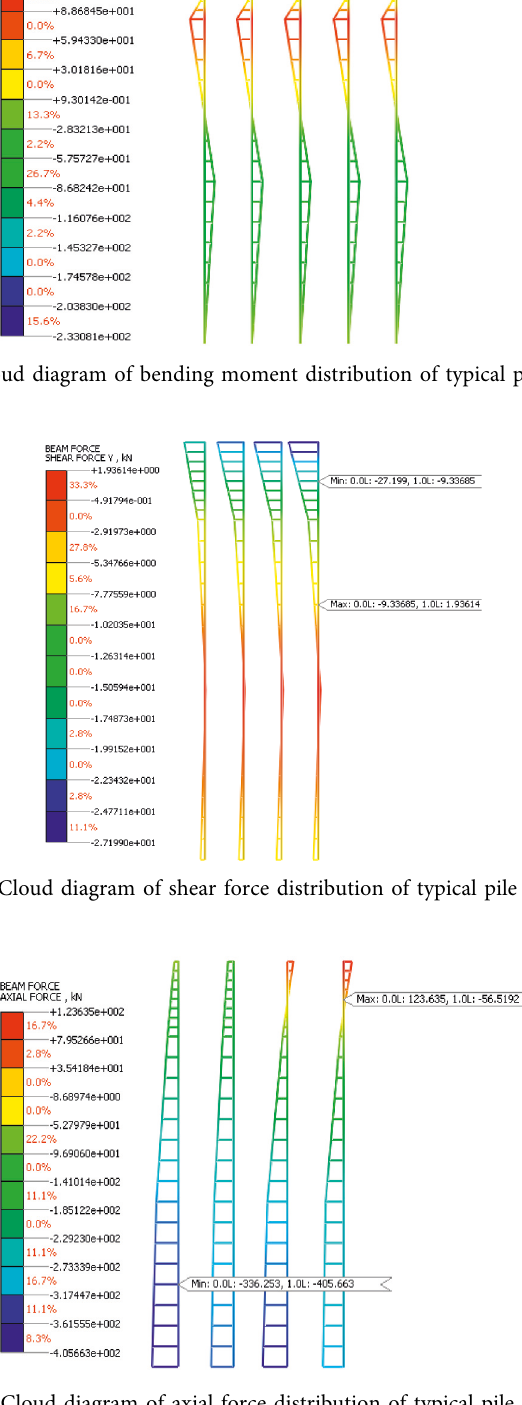
Figure 16: Cloud diagram of axial force distribution of typical pile foundation.